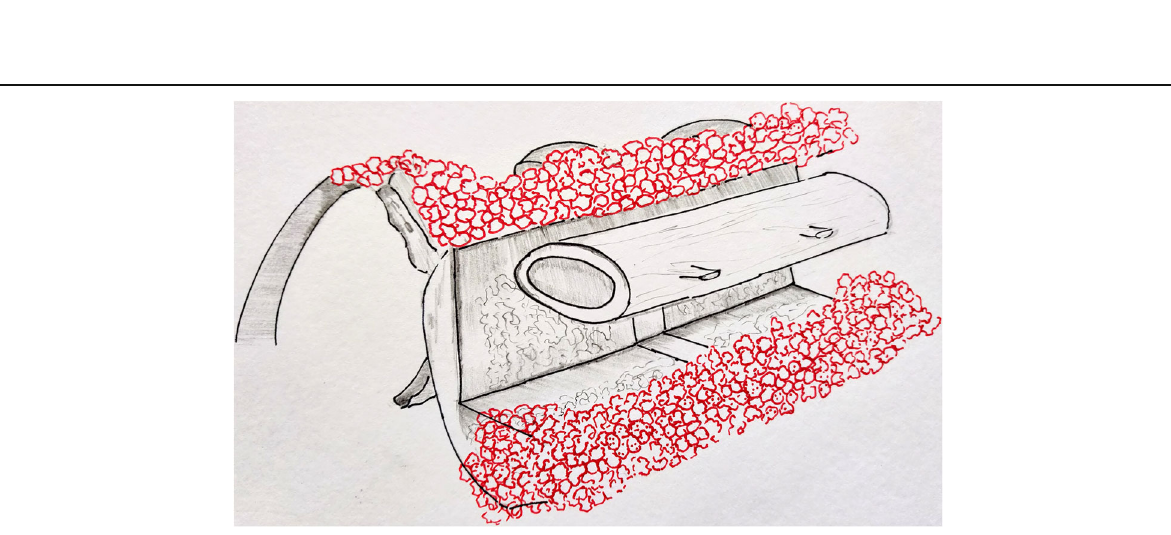
Fig. 7 Illustration showing 360° decompressed cord with bone graft laid on bilateral sides on prepared